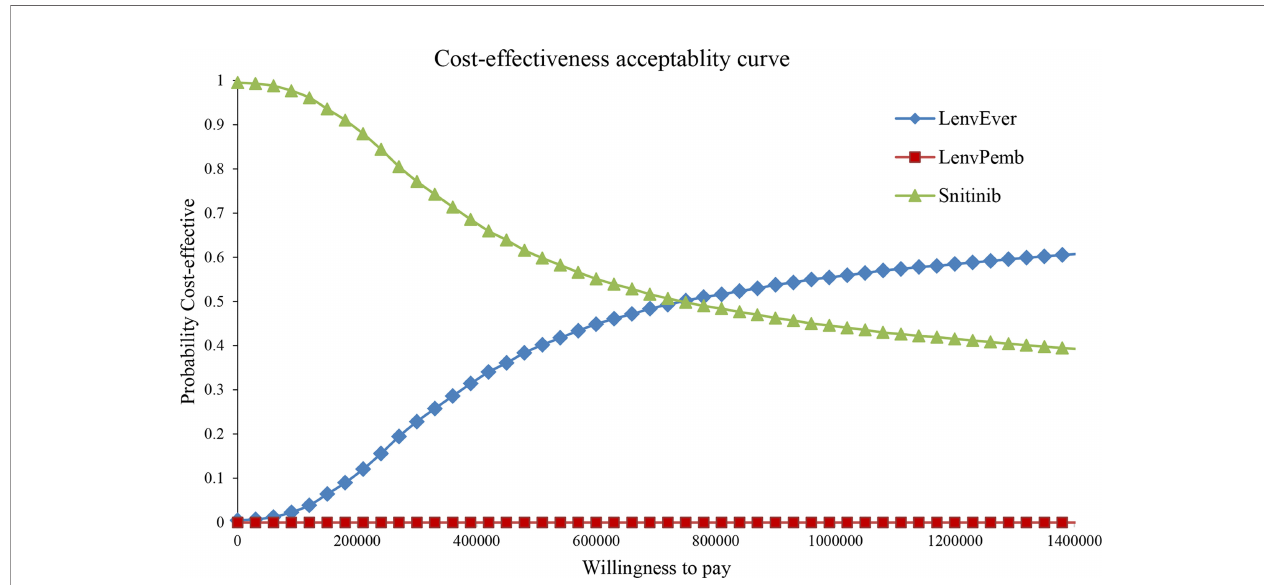
FIGURE 5 | Cost-effectiveness acceptability curve in the Partitioned Survival model. LenvPemb, Lenvatinib-plus-Pembrolizumab; LenvEver,